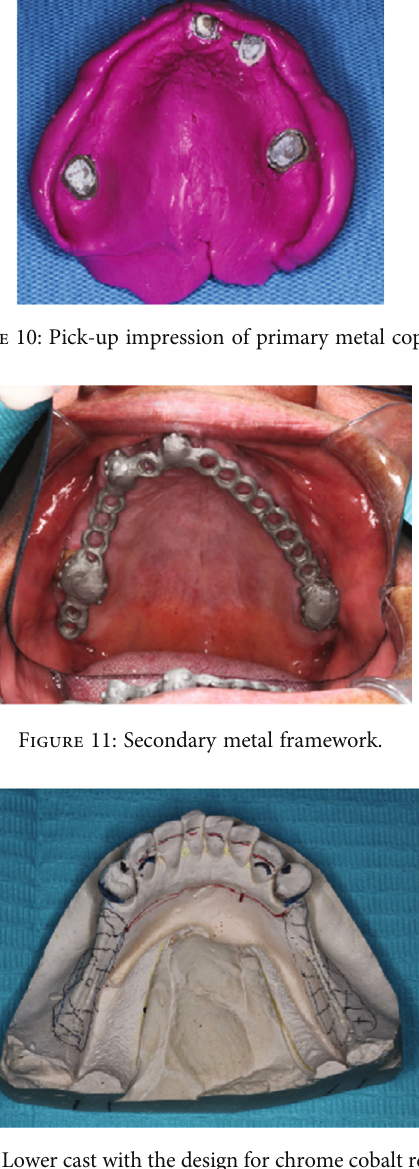
Figure 12: Lower cast with the design for chrome cobalt removable prosthesis.